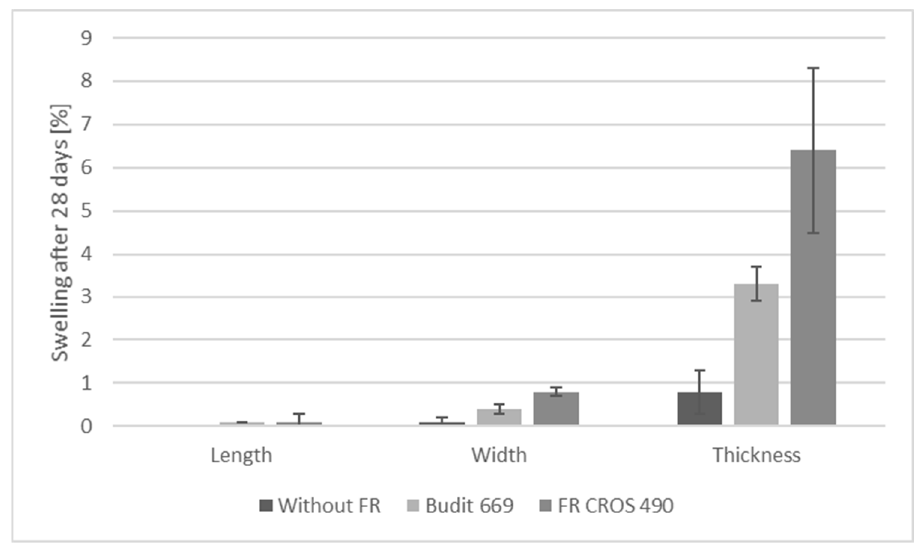
Table 7. Requirements for swelling and water uptake (DIN EN 15534-5).